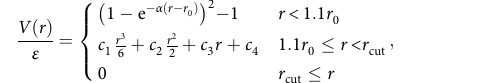
ffiffiffiffiffiffiffiffiffiffiffi p ε m (cid:4) 1 Langevin thermostats with a damping parameter of 0.05 r 0 = . On each body, the thermostats are applied to the three layers of atoms next to the external layer where the fi xed displacement or velocity is imposed. Temperature values provided in Table 1 are expressed in terms of equivalent kinetic energy per atom. The ffiffiffiffiffiffiffiffiffiffiffi p ε m (cid:4) 1 integration is performed with a time step of 0.005 r 0 = Table 1 summarizes the main features of the simulations. Simulation names re fl ect the initial geometry or material heterogeneity: S stands for single asperity, R for rough self-af fi ne surface, H for heterogeneous materials (without grain bound- aries), and G for heterogeneous materials with grain boundaries. In the single- asperity setups S1 – S7, we chose to model semicircular asperities, but different shapes (e.g. square or sinusoidal) are not expected to alter our fi ndings 24 . In simulations H1, G1, and G2, both bodies are modelled by two phases (using two different potentials), present in equal shares and randomly distributed in 500 tiles generated from 500 points randomly distributed in the simulation cell by means of Voronoi tessellation. No grain boundaries between the tiles are modelled in simulation H1. Grain boundaries are modelled in simulations G1 and G2: each of the 500 tiles is a grain, whose orientation is determined by a random rotation, leading to lattice mismatch. In simulations G1 and G2, one of the two potentials is the same used for simulations S1, S2, S3, S4, R1, R2, and H1, and it is characterized by τ sf = 3.52 ε r (cid:4) 2 0 (cf. Table 1). The other adopted potential has the same equili- brium energy ε , but its equilibrium and cut-off distances are scaled by a factor